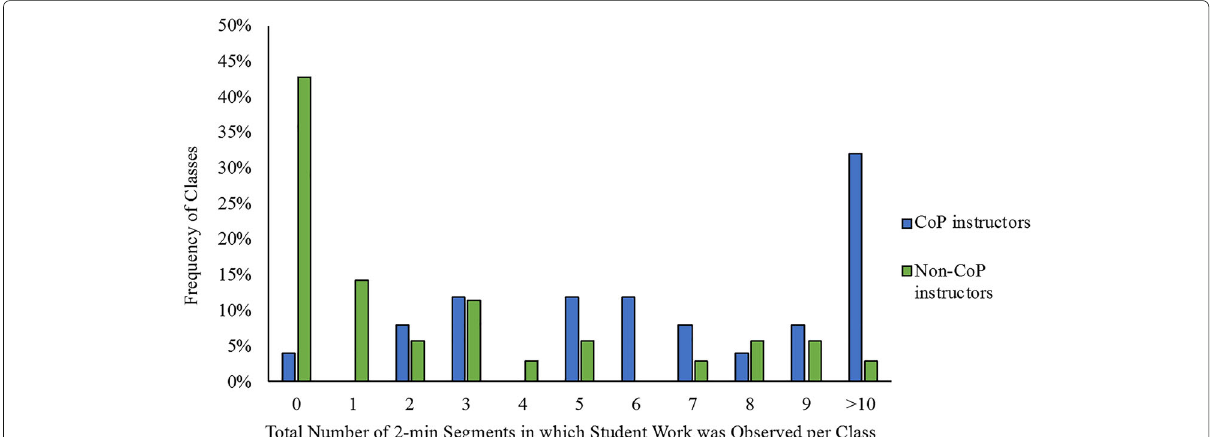
Fig. 2 Student working histogram. Distribution of the frequency of classes in which the collapsed COPUS category of student work was observed, indicated by the total number of 2-min segments, for CoP ( n = 25) and non-CoP ( n = 35)